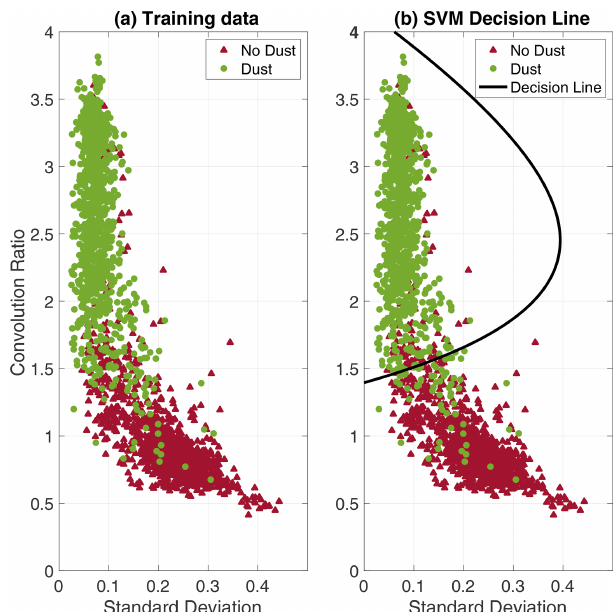
Figure 4. (a) The (1 × 2) feature vectors extracted from all (2400) observations in the training data, the associated labels are indicated in green ( dust ) and red ( no dust ). (b) The SVM decision line is defined as a second-order polynomial, obtained by minimizing the non-separable SVM cost function. The optimized SVM decision line appears to be reasonable, and most observations are separable in the training